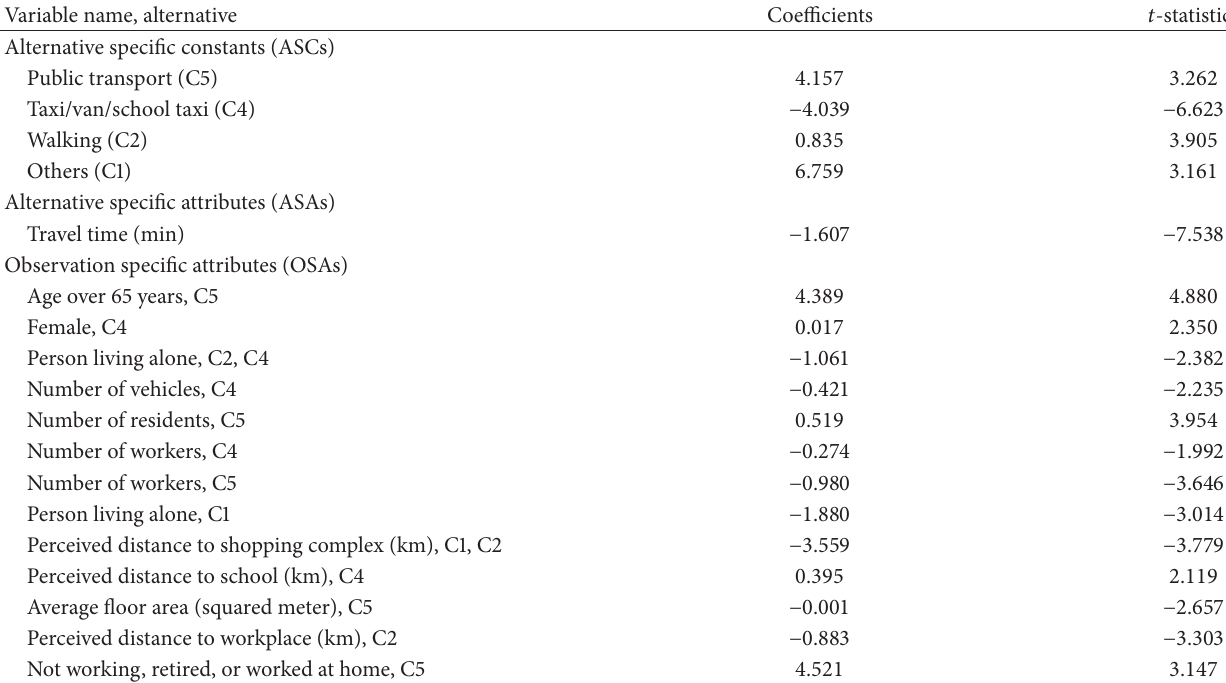
Table 3: The nonwork modal choice (all three